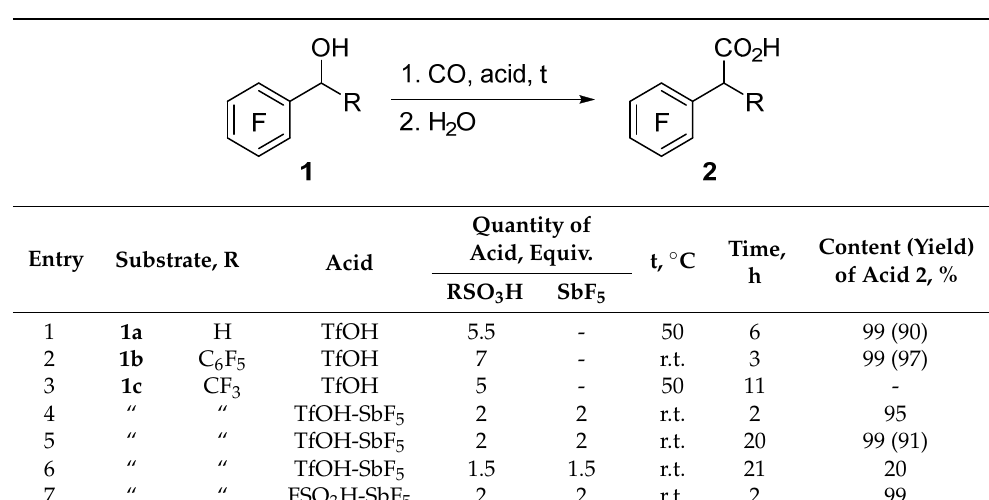
Table 1. Carbonylation of primary and secondary alcohols C 6 F 5 CH(OH)R 1a – c in